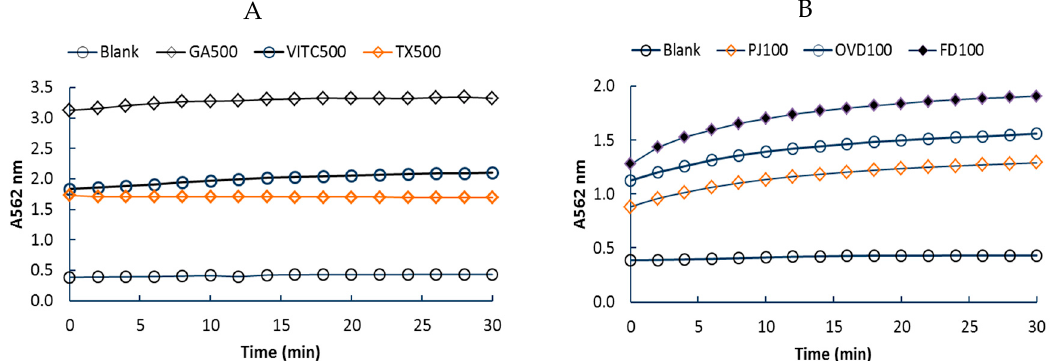
Figure 1. Typical time course traces for absorbance readings at 562 nm (A562) for iron (III) reducing antioxidant capacity ( iRAC ) method; ( A ) Gallic acid (GA500), vitamin C (VITC500), or trolox (TX500) were reference compounds (500 uM), ( B ) Timed response for pomegranate juice or pomegranate extracts (5 g/100 mL) prepared with 40:60 v / v methanol/water) and diluted 100 × before analysis. PJ100 = pomegranate juice, OVD100 = extract from oven-dried sample, FD100 = extract from freeze-dried sample.